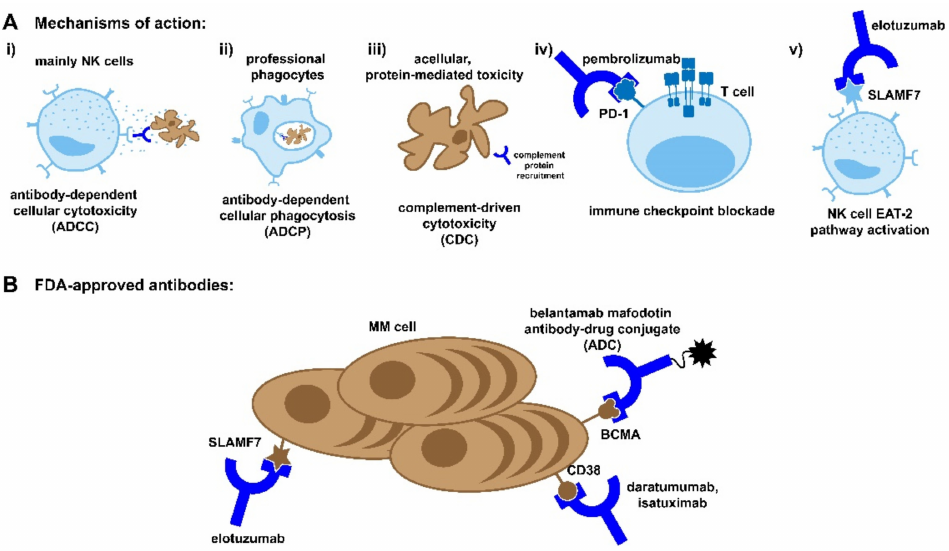
Figure 1. Antibody based therapies. ( A ) The mechanisms of action for monoclonal antibody and antibody-drug-conjugate therapies. As antibodies already play a role in the immune response against pathogens, these therapies harness the same pathways to elicit both cellular- and acellular-mediated toxicity of the target cell. These pathways include canonical killing of the target cell by immune cells (( i ) ADCC, ( ii ) ADCP, and ( iii ) complement) as well as the “reprogramming” of immune cells to reactivate against the target cell (( iv ) immune checkpoint blockade and ( v ) EAT-2 activation). ( B ) In addition to checkpoint blockade antibodies, there are several FDA-approved monoclonal antibodies and drug conjugates currently available to treat MM, which target several common markers of myeloma